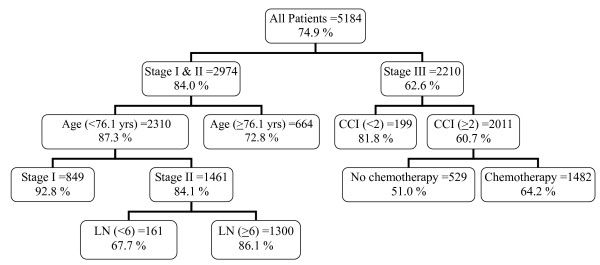
Decision tree constructed by recursive partitioning analysis (test sample). The plots of recursive partitioning analysis (Figure 2 and Figure 3) were obtained from 10,494 patients who were documented to have adenocarcinoma from colon and rectum (anus was not included) and underwent colorectal resection for cancer. (CCI: Charlson comorbidity index; LN: number of lymph nodes; yrs: years; the number in the upper half of box indicated number of patients; the percentage in the upper half of box indicated cancer-specific survival percentage).